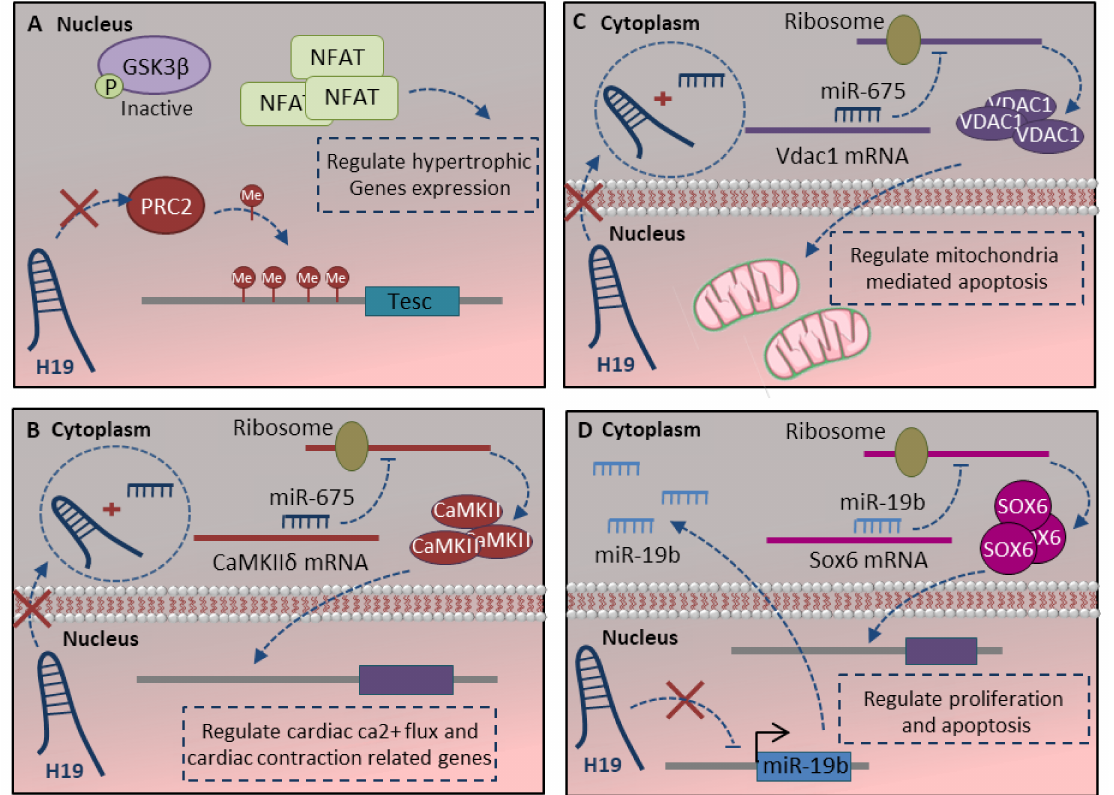
Figure 4. Regulatory effect of H19-LncRNA in cardiomyocyte maturation. ( A ) H19 regulates the cardiomyocyte maturation process at different steps, including apoptosis, proliferation, hypertrophy and contraction. A. H19 physically interacts with PRC2 to suppress pro-hypertrophic NFAT signaling. ( B ) H19 regulates the cardiac ca2+ flux and cardiac contraction function through the H19-miR-675-CamkII δ axis. ( C , D ) The regulatory function of H19 lncRNA in mitochondrial apoptotic pathway and cardiomyocyte proliferation is mediated through either H19-miR-675-Vdac1 ( C ) or H19-miR-19b-Sox6 ( D ) axis. More details are described within the